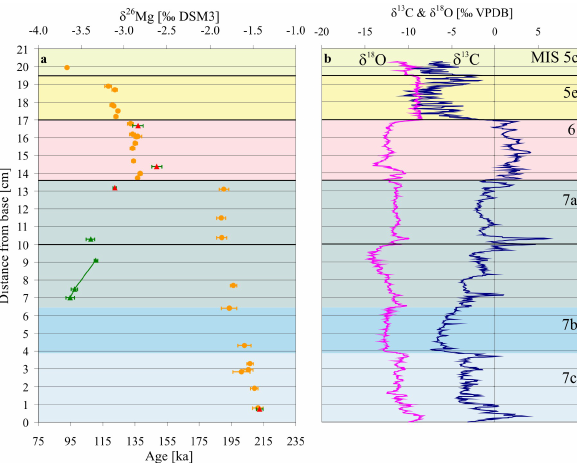
Fig. 8. Magnesium, carbon and oxygen data of the stalagmite HK3 from Grotte Prison de Chien , Morocco. (a) Mg-isotope data plotted against depth of the transect (top at 0mm). (b) Carbon (dark blue) and oxygen (magenta) isotope data plotted against depth (data from Wassenburg et al., 2012). Colour code refers to aragonite and calcite intervals, respectively.